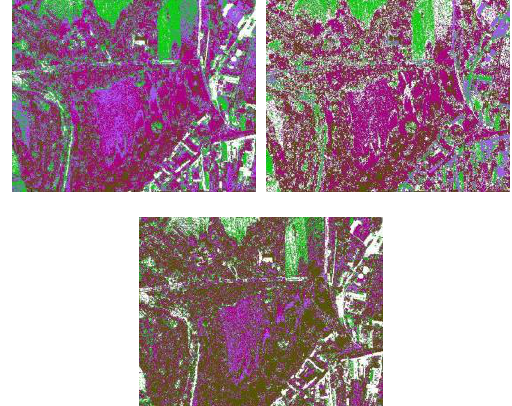
Figure 5: Reclassification of reconstructed image with Anisotropic Procrustes method. In order ML, KM, SOM classifier